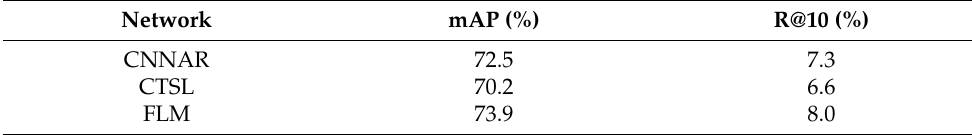
Table 5. Retrieval accuracy of different models in Corel5K.